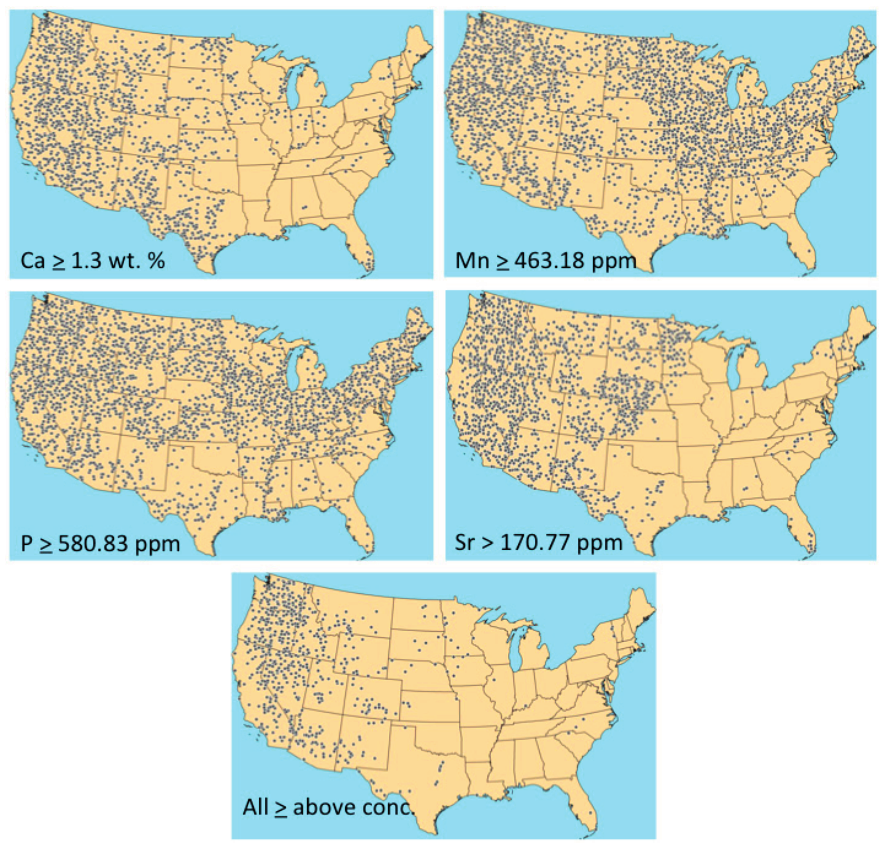
Figure 4. USGS Geochemical Landscape Project sample sites where the average statistically significant concentrations of Ca, Mn, P and Sr were equal to or exceeded 1.3 wt %, 463 mg/kg, 580 mg/kg and 170 mg/kg, respectively. Individual maps and one combined showing the sites where each of these concentrations